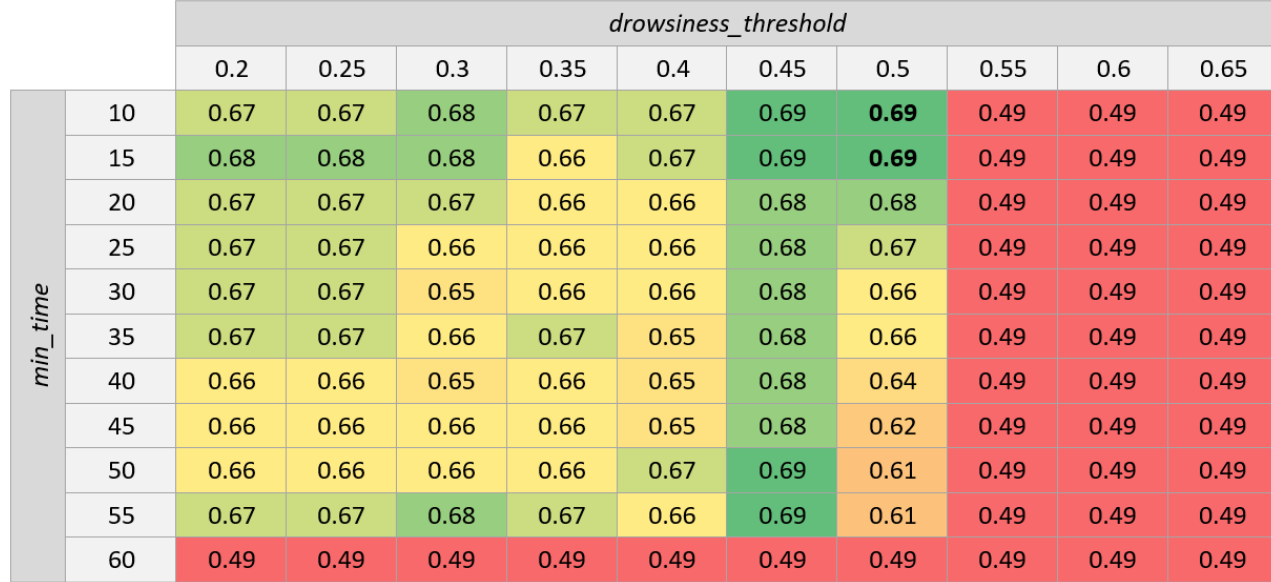
Figure 12. Accuracy obtained by Alternative II over training data. Minimun value is colored red. Median value is colored yellow. Maximum value is colored green. All other cells are colored proportionally. The best (max. accuracy with min. false positives) values are shown in bold.